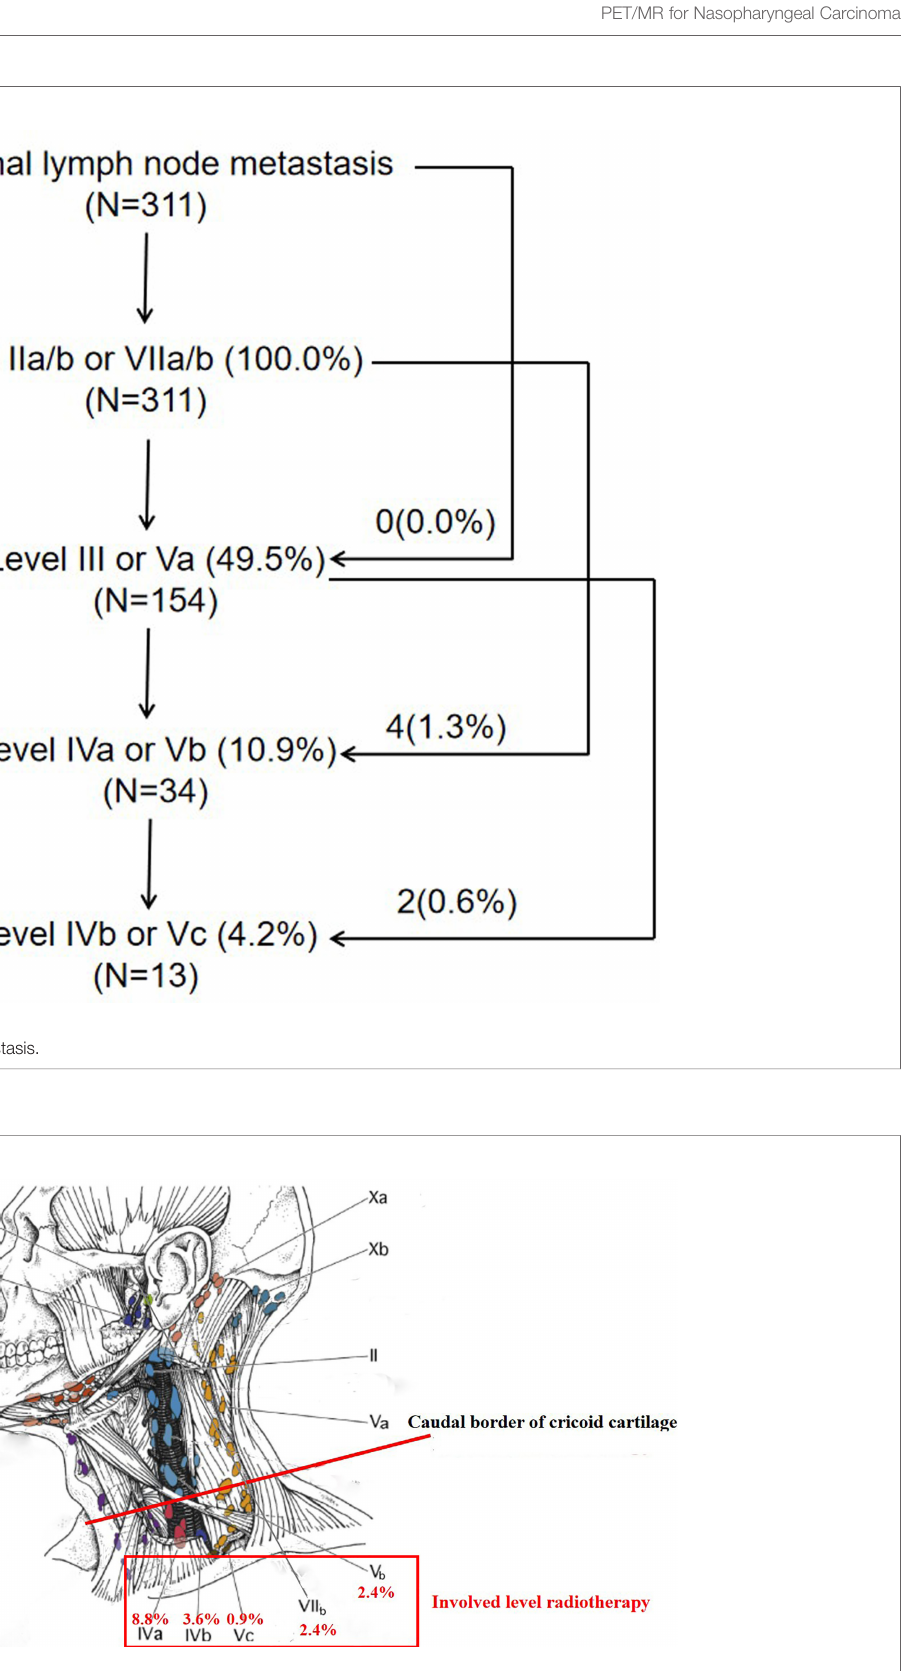
FIGURE 3 | Involved level radiotherapy for nasopharyngeal